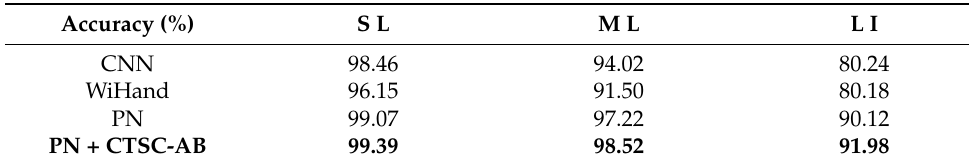
Table 5. Comparison study of different recognition